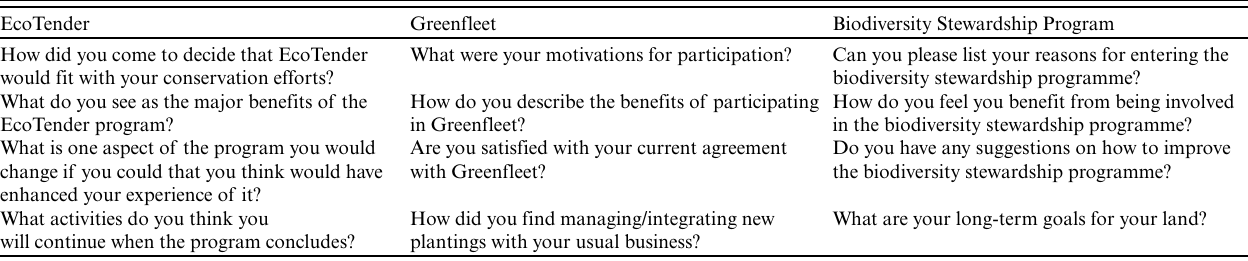
Table 2 . Case study